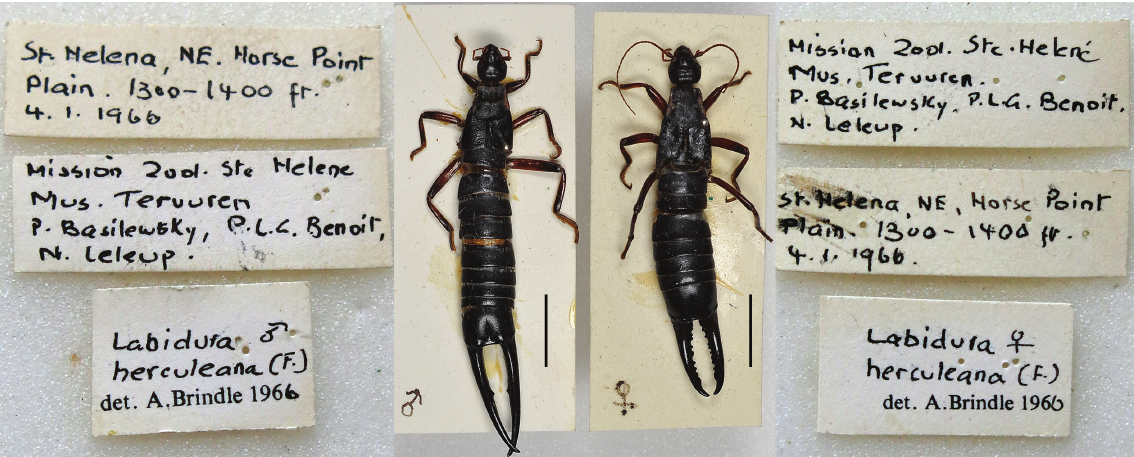
Fig. 12. Male and female specimens of Labidura herculeana (Fabricius, 1798), with corresponding data labels; MMUE, accession numbers F3233.1871 and F3233.1872. Scale bar = 1